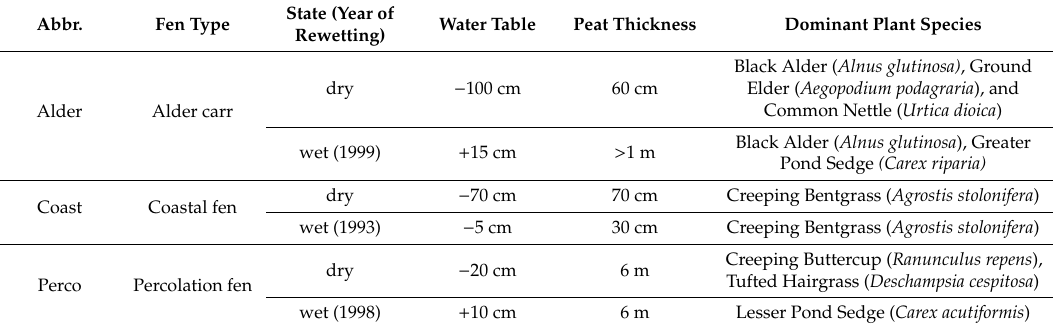
Table 1. Sampling site